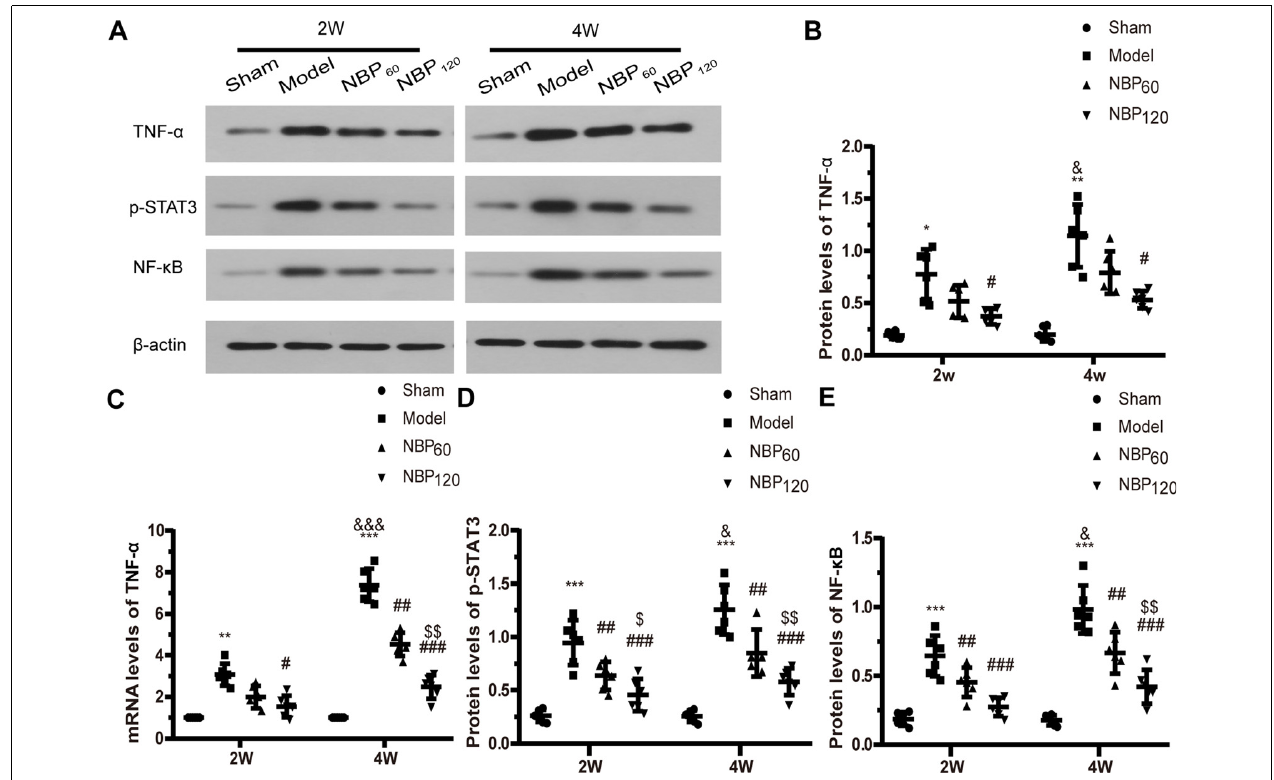
FIGURE 6 | Dl-3-n-butylphthalide (NBP) suppresses inflammation induced after 2VO. (A) Western blot analysis of the expressions of TNF-a, p-STAT3 and NF-KB ( n = 6 in each group). (B) Quantitative analysis of protein levels of TNF- α . (C) Quantitative analysis of mRNA levels of TNF- α ( n = 6 in each group). (D) Quantitative analysis of protein levels of p-STAT3. (E) Quantitative analysis of protein levels of NF-KB. β -actin was used as an internal control. * p < 0.05, ** p < 0.01, *** p < 0.001, the model group vs. the sham group; # p < 0.05, ## p < 0.01, ### p < 0.001, the NBP60 group or NBP120 group vs. the model group; $ p < 0.05, $$ p < 0.01, the NBP60 group vs. NBP120 group; & p < 0.05, &&& p < 0.001, the model group sacrificed at 2 weeks vs. the model group sacrificed at 4 weeks. Values are expressed as mean ± SD. TNF- α , tumor necrosis factor- α . p-STAT3, phosphorylated signal transducers and activators of transcription 3. NF- κ B, nuclear factor κ